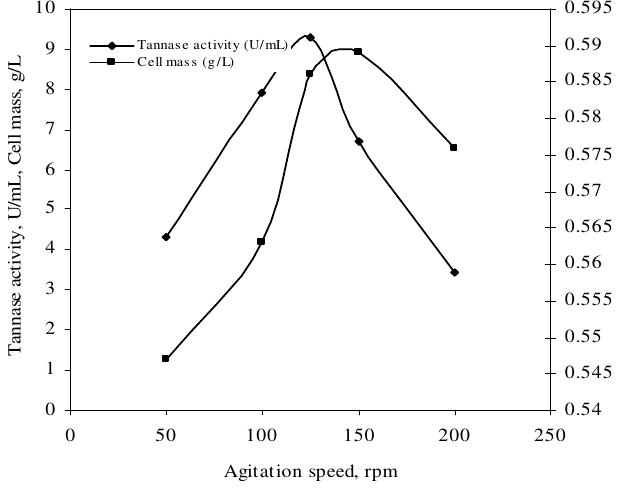
Figure 4. Effect of agitation speed on tannase